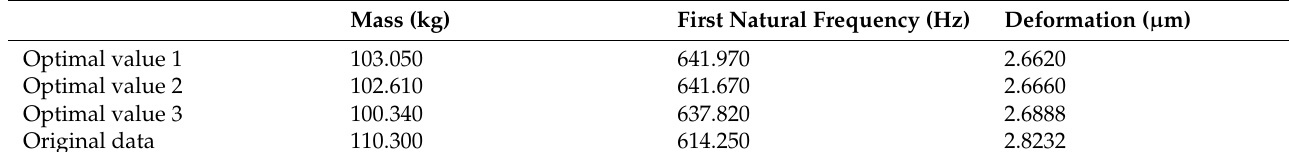
Table 12. Original data and optimization values of optimization objectives.